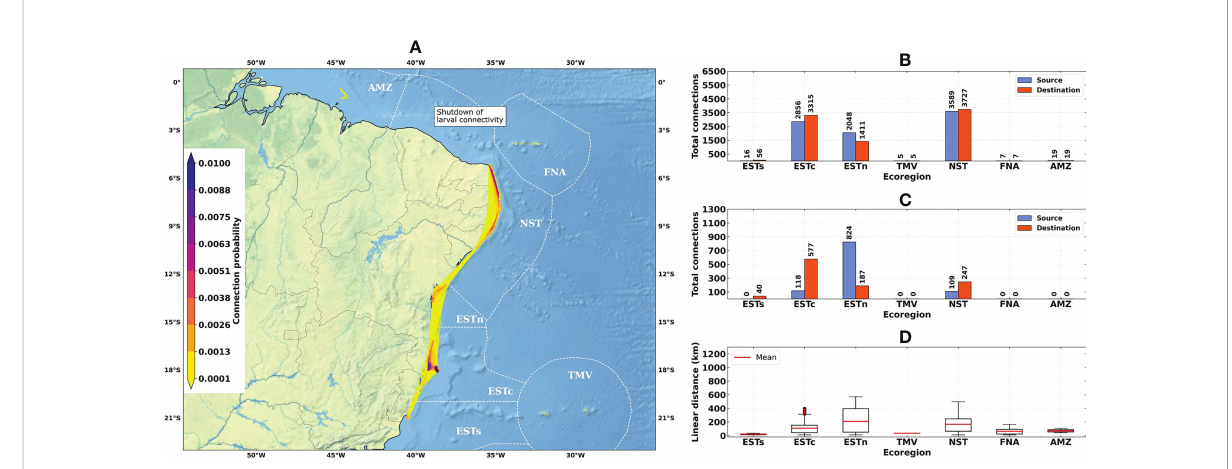
FIGURE 6 Connectivity patterns obtained from the larval connectivity model, considering the average of dispersal simulations between August – September – October for the La Niña years (1998 – 1999 and 2010 – 2011): (A) Distribution of connection probabilities between reef sites; (B) Total number of connections given source (in blue) and destination (in orange) ecoregions; (C) Number of connections given source (in blue) and destination (in orange) ecoregions, disregarding connections between reef sites within the same ecoregion; (D) Linear distances from connections between the source and destination reef sites. Ecoregions: Eastern-south (ESTs); Eastern-center (ESTc); Eastern-north (ESTn); Northeastern (NST), Amazon (AMZ), Fernando de Noronha-Atol das Rocas (FNA), Trindade-Martim Vaz Islands